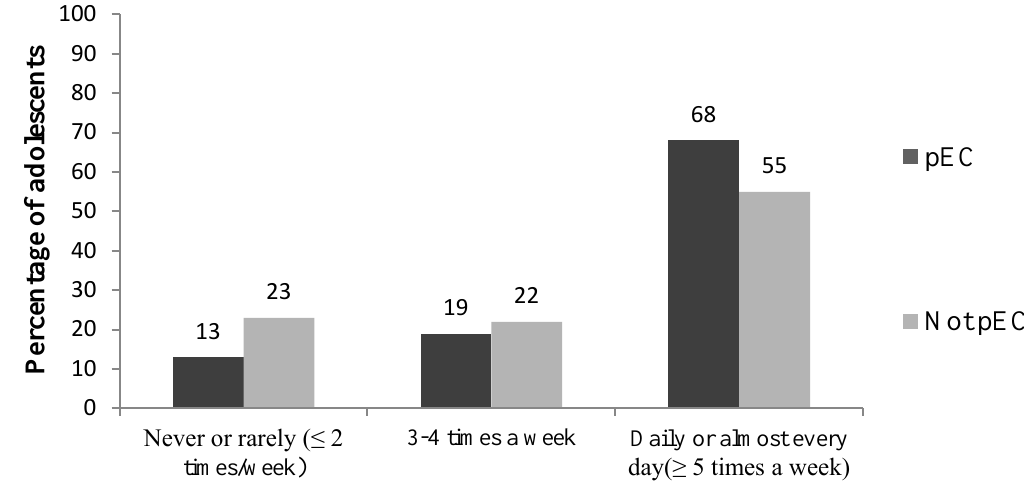
Figure 4. Family meal frequency in the presumably eating competent (pEC) and not eating competent (not pEC) groups (percentage of adolescents, n = 971 out of 976). Frequencies were generated by cross-tabulations using chi-square test for statistical significance, p <